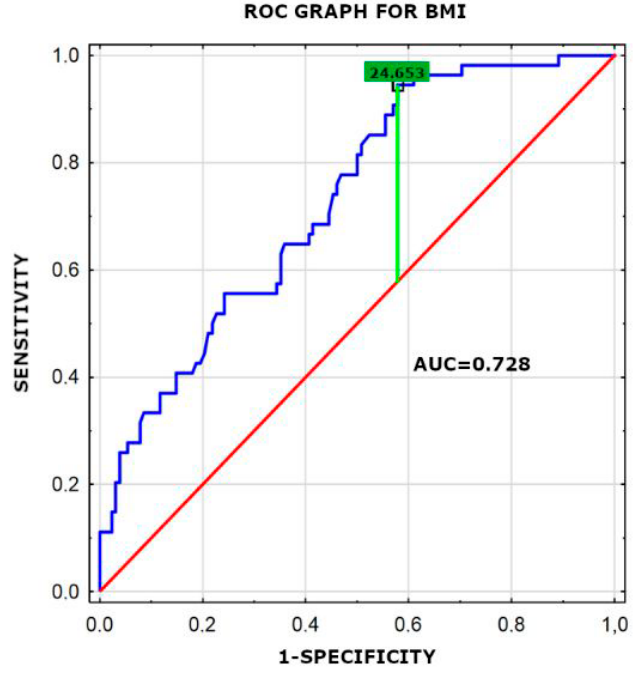
Figure 2. Receiver-operating characteristic curve (ROC) for the BMI variable revealing its diagnostic potential. AUC -area under the ROC curve. Table 5. Multivariate analysis—stepwise logistic regression.